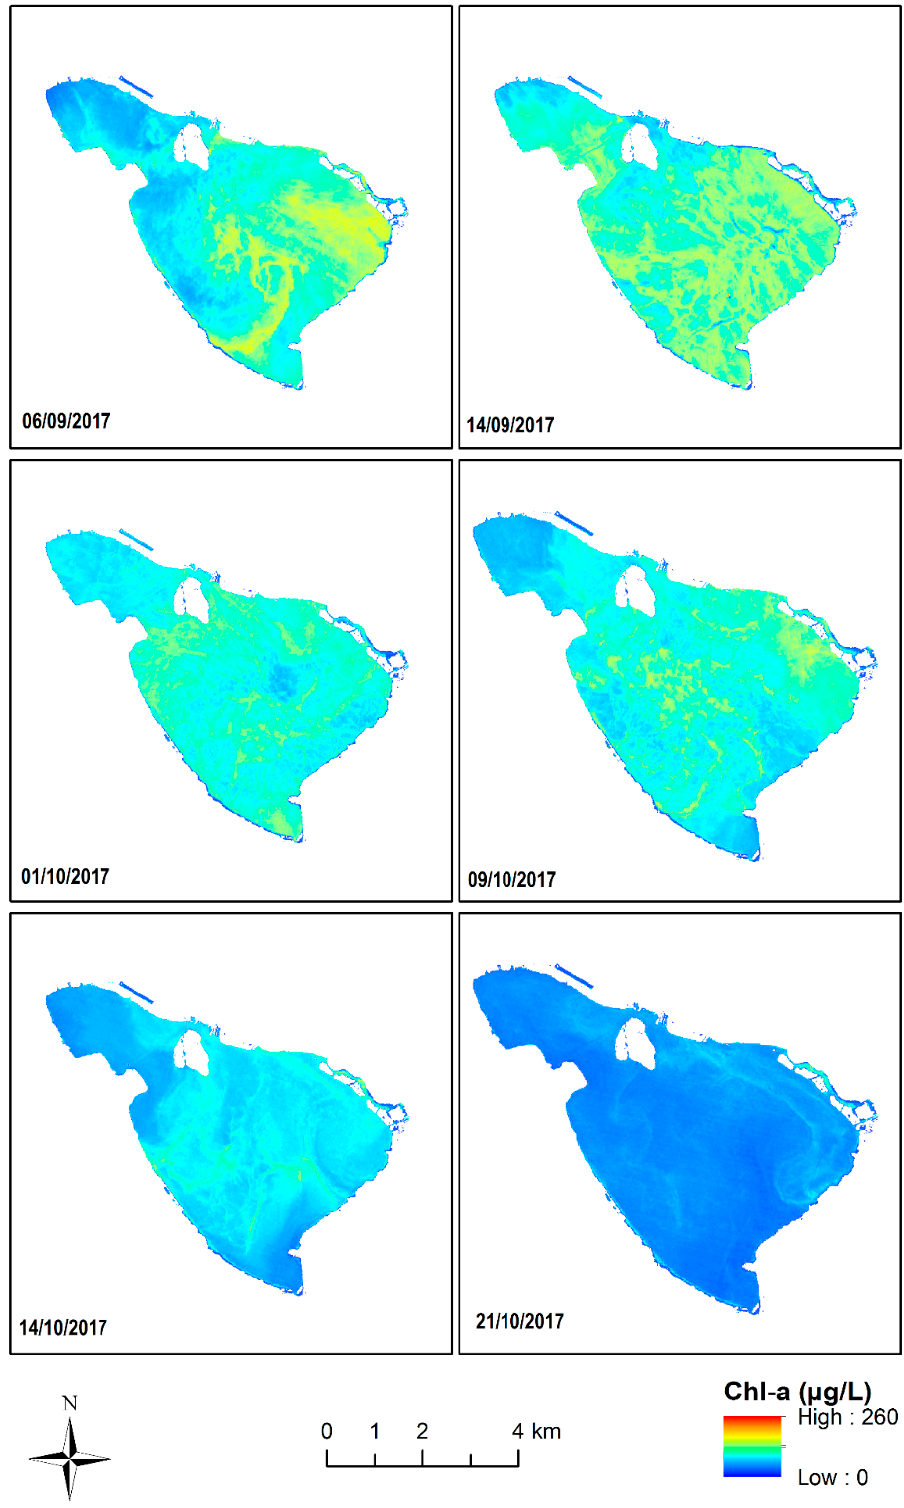
Figure 5. Outbreak of chl- a concentrations for September–October 2017. Only the available images without any cloud contamination have been processed.